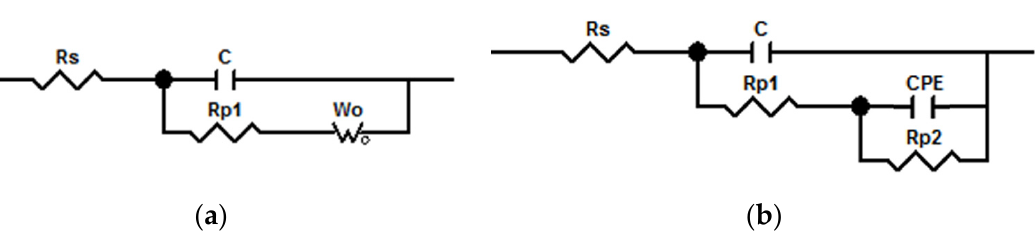
Figure 5. Equivalent electric circuit models with two time constants of ( a ) pure WPU coating and ( b ) WPU SCCs.